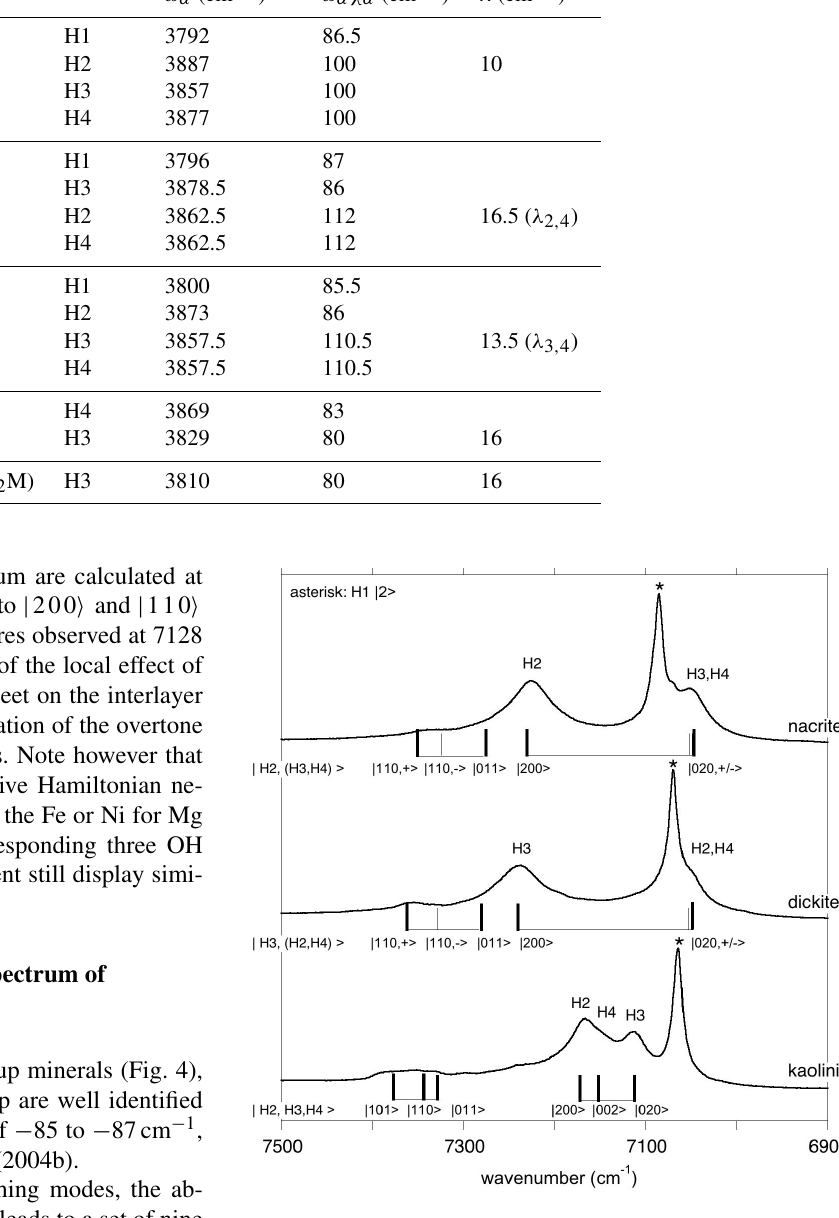
Figure 4. Assignment of OH overtone transitions in kaolinite group minerals. Transitions calculated for a molecular cluster are indi- cated by the vertical bars labelled with the corresponding excited states (Table 3). The thick vertical bars denote an expected stronger absorption intensity due to the symmetry of the excited state. In the model Hamiltonian, the OH3 and OH4 groups of nacrite and OH2 and OH4 groups of dickite are treated as equivalent oscillators. The asterisk indicates the overtone of the inner OH-stretching